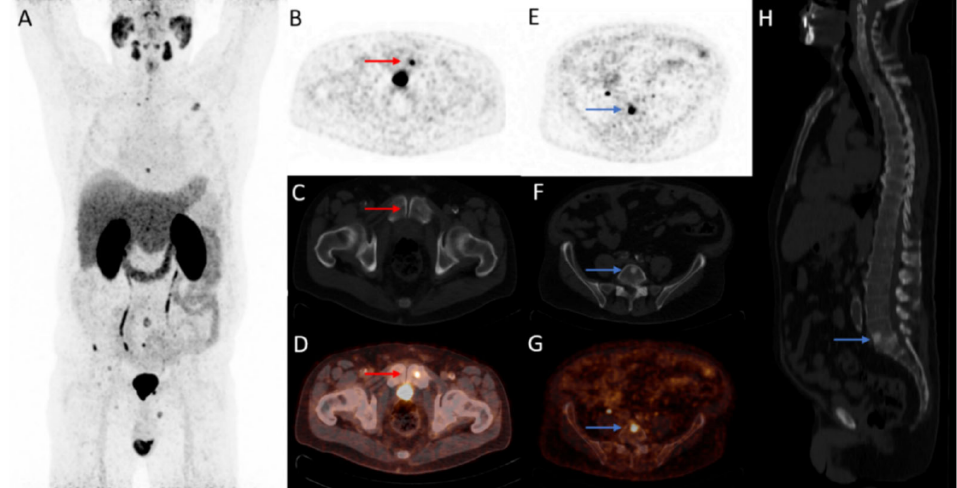
Figure 1. A 70-year-old patient with biochemical recurrence after radical prostatectomy (Gleason 3 + 4 = 7, PSA-nadir < 0.1 ng/mL) with a PSA of 0.7 ng/mL at the PET/CT scan time. Restaging 18 F- DCFPyL PET/CT detected multiple bone metastases (>10) at low serum PSA value (( A ); maximum intensity projection). Transversal 18 F-DCFPyL PET ( B , E ) and fused PET/CT ( D , G ) images illustrate two bone metastases (os pubis left, red arrow: SUV max : 9.76; L5 vertebra, blue arrow SUV max : 8.02) with sclerotic substrate on CT ( C , F , H